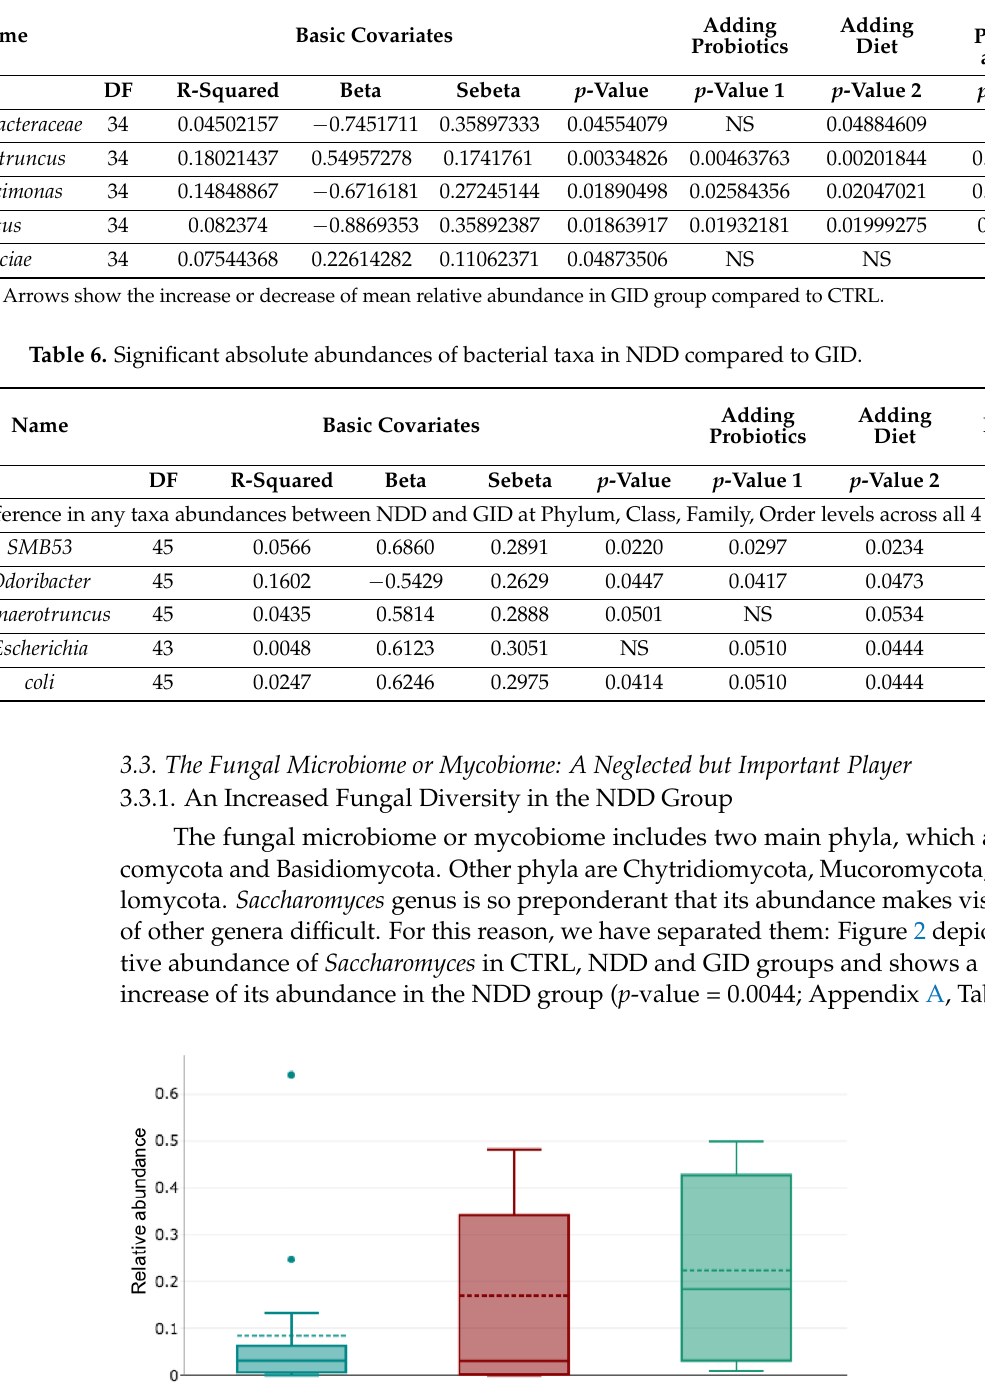
Table 5. Significant relative abundances of bacterial taxa in GID compared to CTRL.